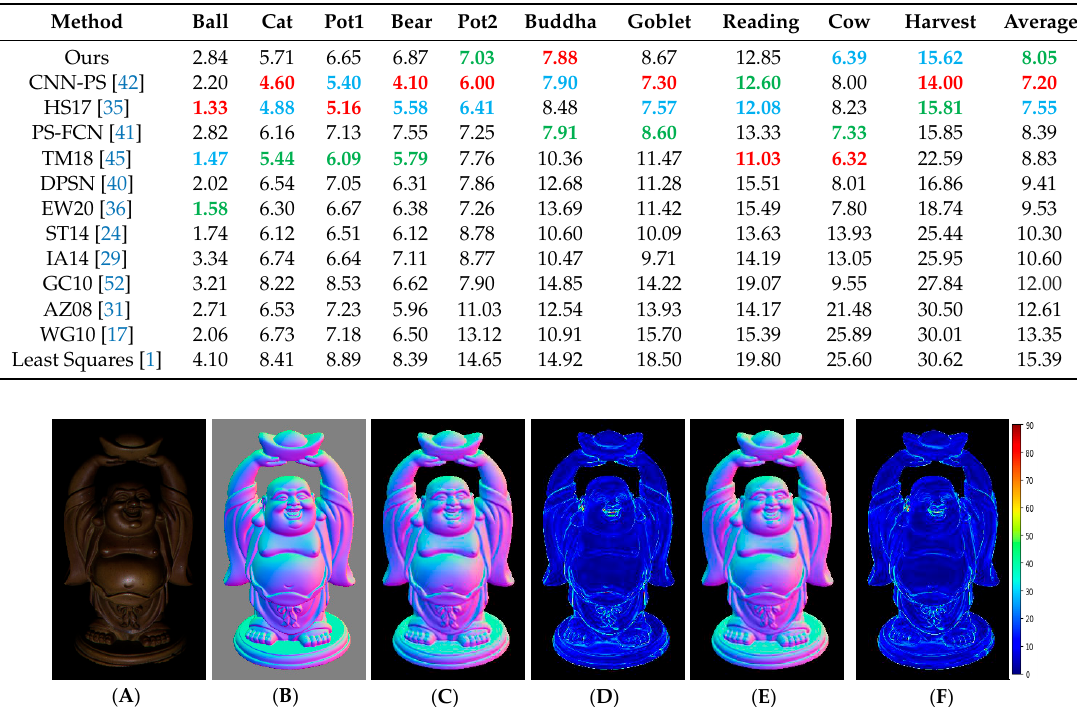
Table 1. Accuracy comparison for the DiLiGenT benchmark in the surface normal estimation of calibrated photometric stereo methods. The value indicates the mean angular errors in degrees for estimated surface normal where red, blue, and green indicate the best, second-best, and third-best performances, respectively.